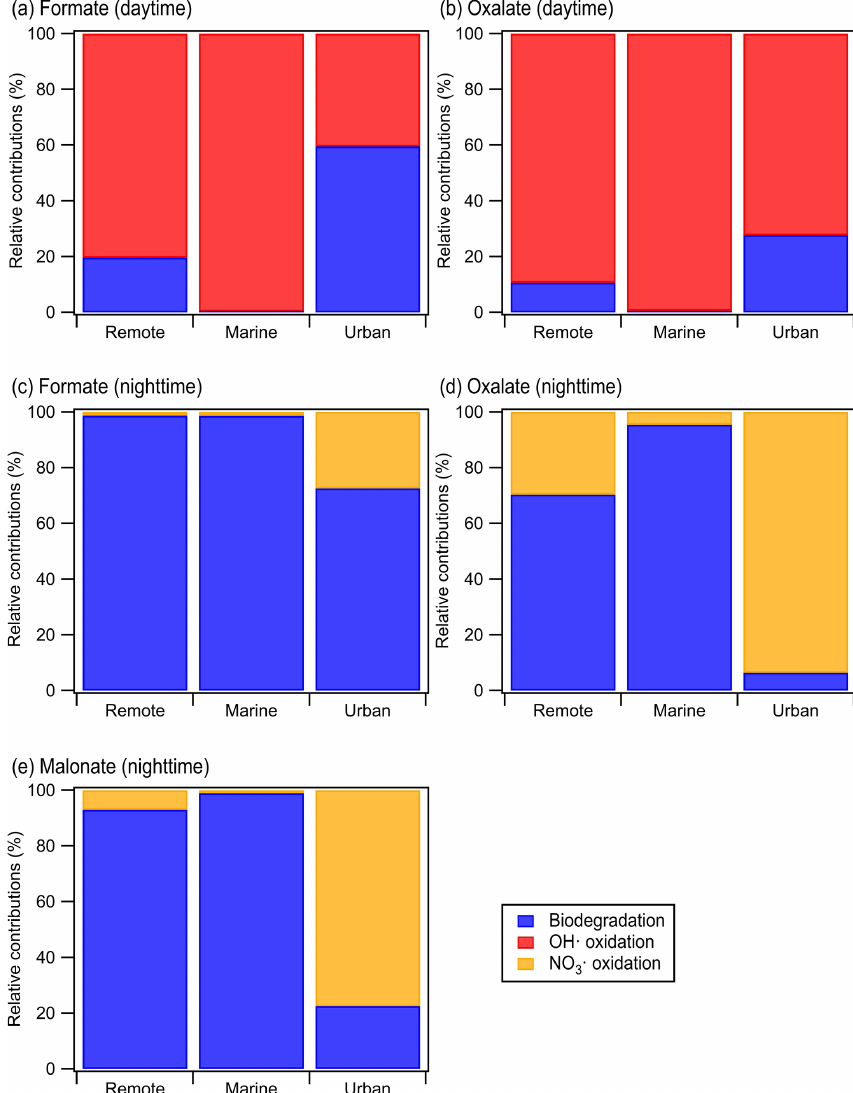
(cid:113) (cid:113) OH oxidation for daytime and NO 3 for nighttime)